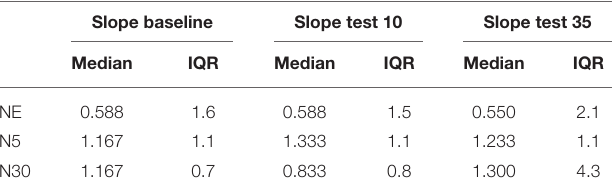
TABLE 4 | Median and interquartile range of the slope of pain ratings at baseline, test 10 and Test 35 in the three experimental groups. Slope baseline Slope test